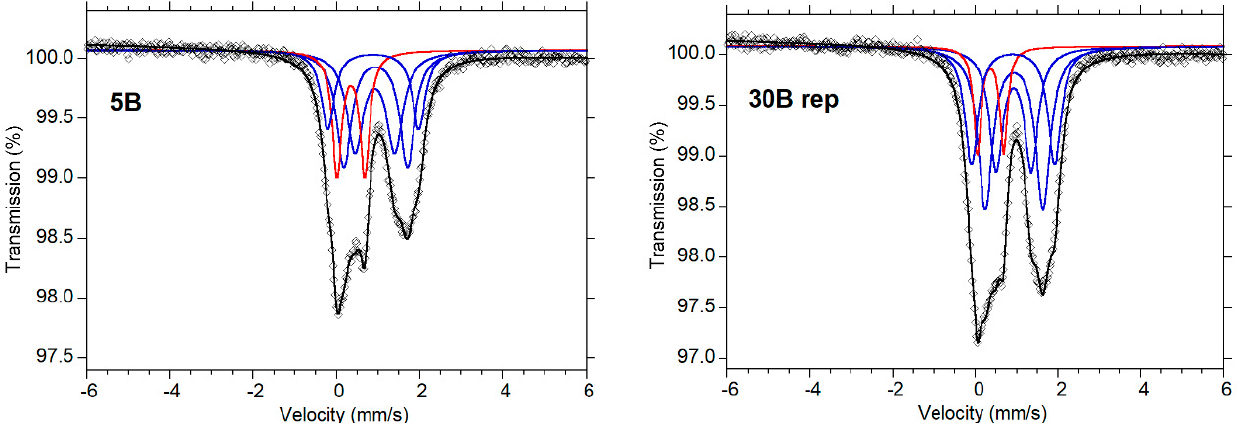
Figure 3. Examples of 57 Fe Mössbauer spectra obtained at room temperature for samples 5B and 30B rep. Fitted absorption doublets assigned to Fe 2+ and Fe 3+ are indicated in blue and red colors, respectively. Diamond symbols denote measured spectra, and the black curves represent summed fitted spectra.